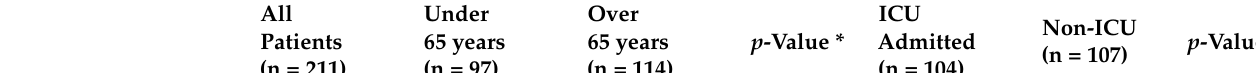
Table 2. Results and group